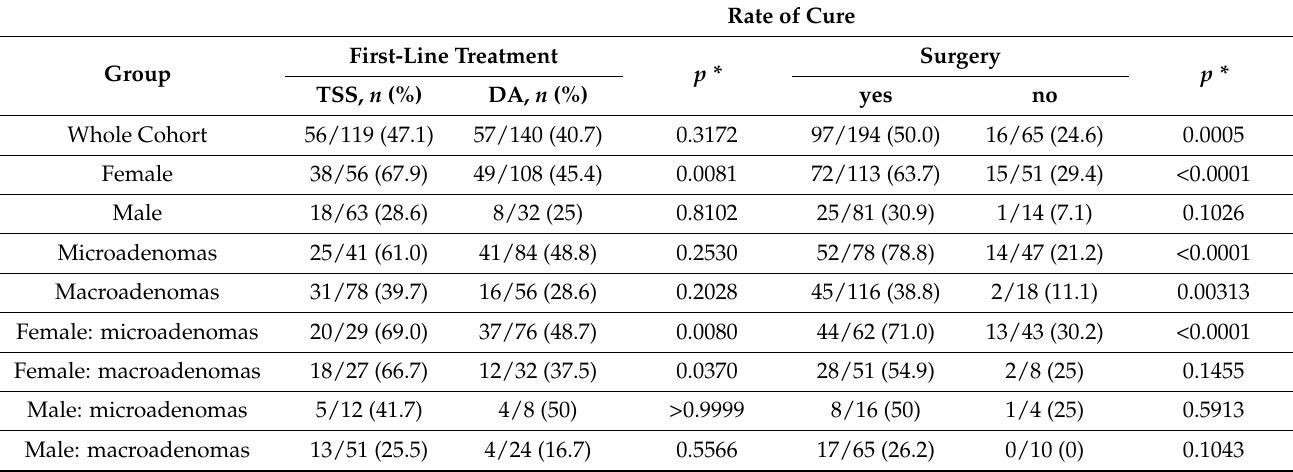
Table 3. Rate of a cure depending on the first-line treatment and surgery in the whole cohort.